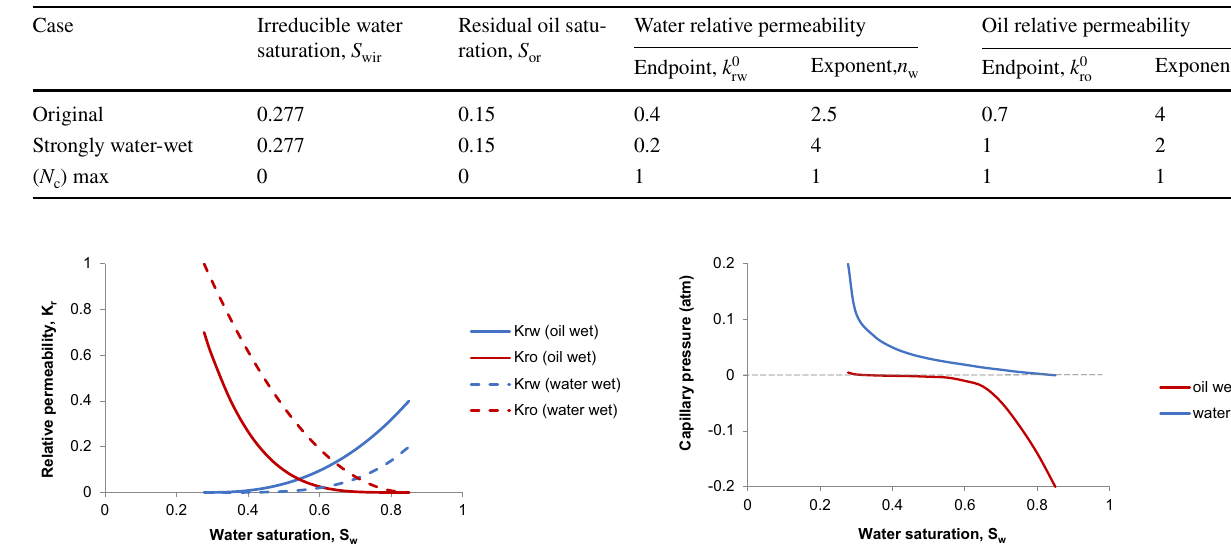
Table 5 Key parameters for water and oil relative permeability